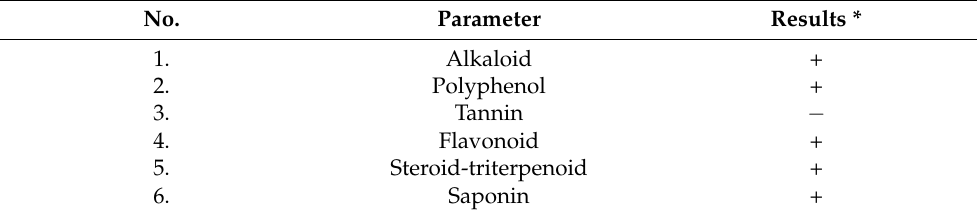
Table 2. Phytochemical screening parameters of Calophyllum soulattri leaves extract. No. Parameter 1.